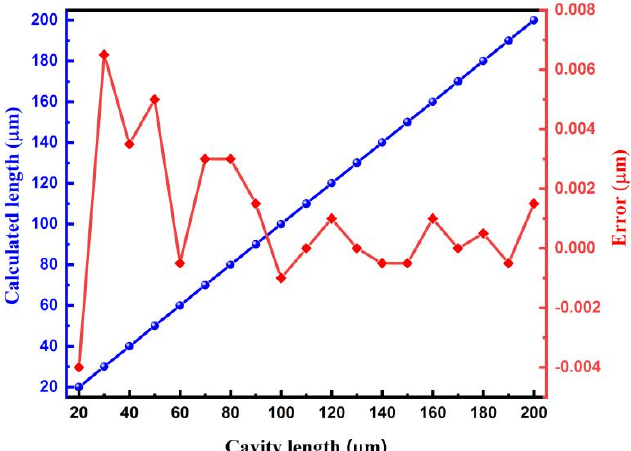
Figure 6. Calculated cavity lengths ( left ) and deviation errors ( right ) for fiber-optic F–P sensors in the range of 20–200 μ m.